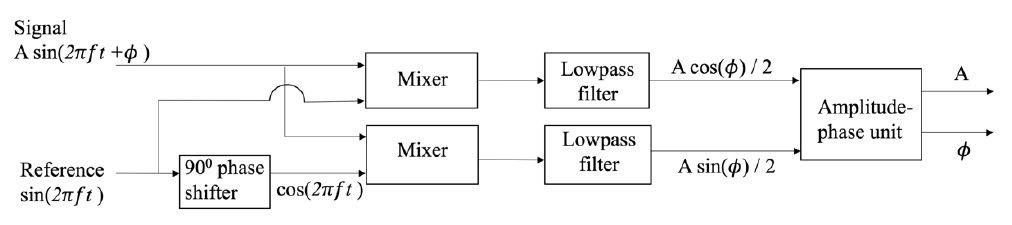
Figure 13. Block diagram of a conventional dual-phase lock detection system.